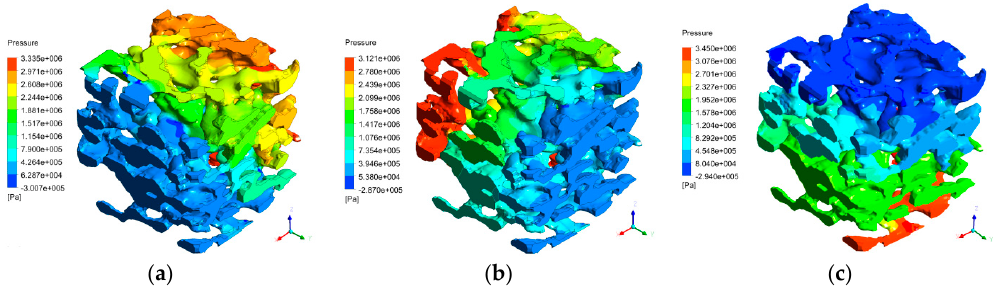
Figure 10. Distributions of pressure subject to low-pressure water along a single-channel in X , Y , and Z directions: ( a ) X direction; ( b ) Y direction; and ( c ) Z direction.